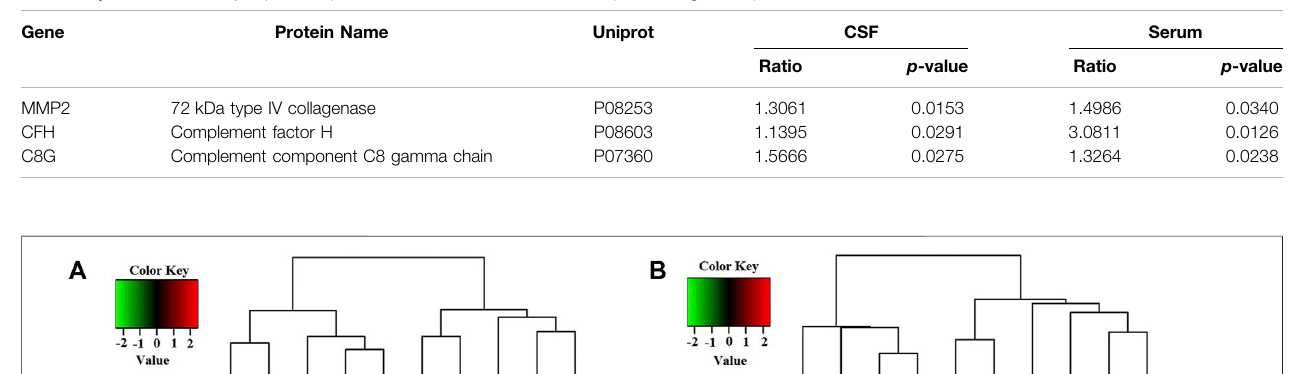
TABLE 2 | Three differentially expressed proteins common in CSF and serum (Fold change = 1.2).